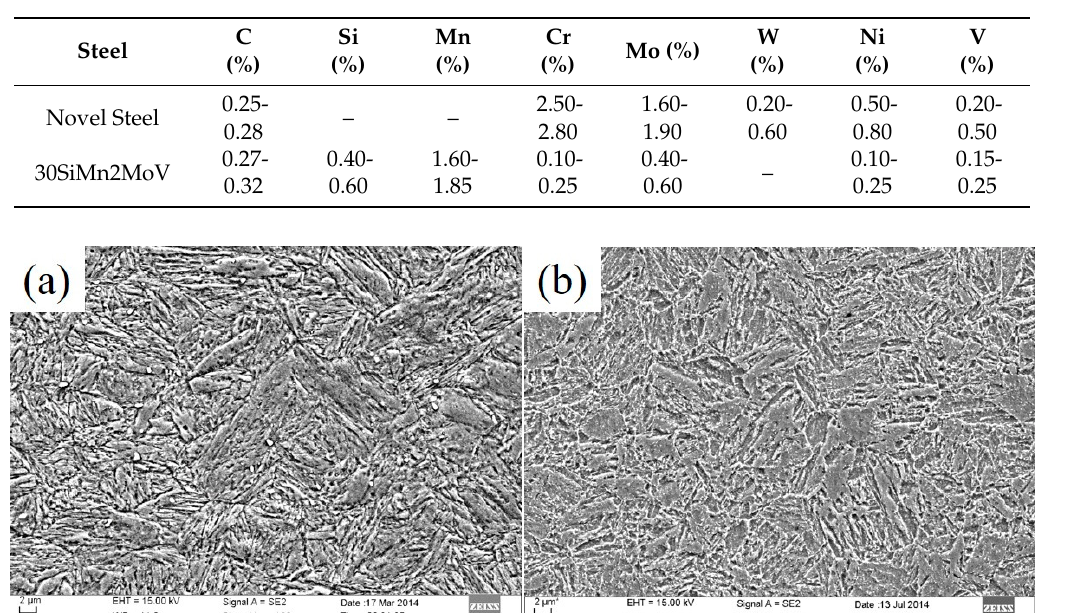
Table 1. Comparison of the chemical composition between the novel steel and 30SiMn2MoV steel.